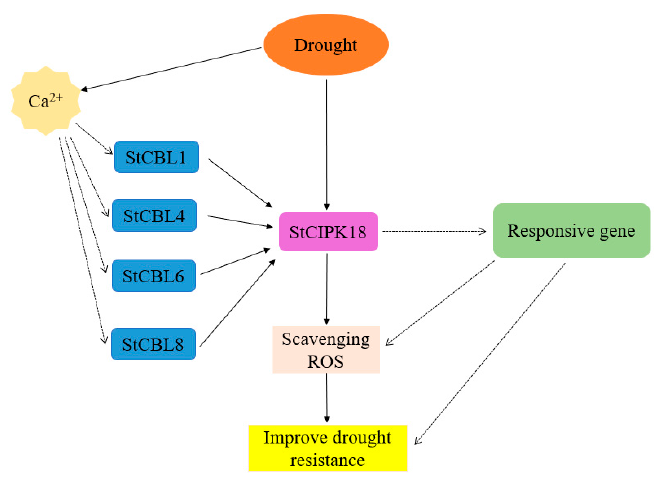
Figure 6. Prediction pathway model of potato StCIPK18 response to drought stress. StCIPK18 regulates the ability of plants to remove ROS to improve drought tolerance. CBLs can receive Ca